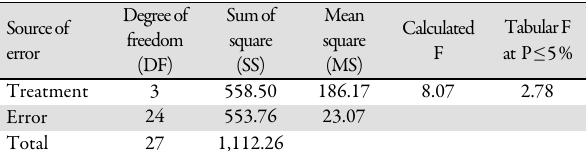
Table 4. ANOVA for the height of tomato plants in the consumptive use experiment